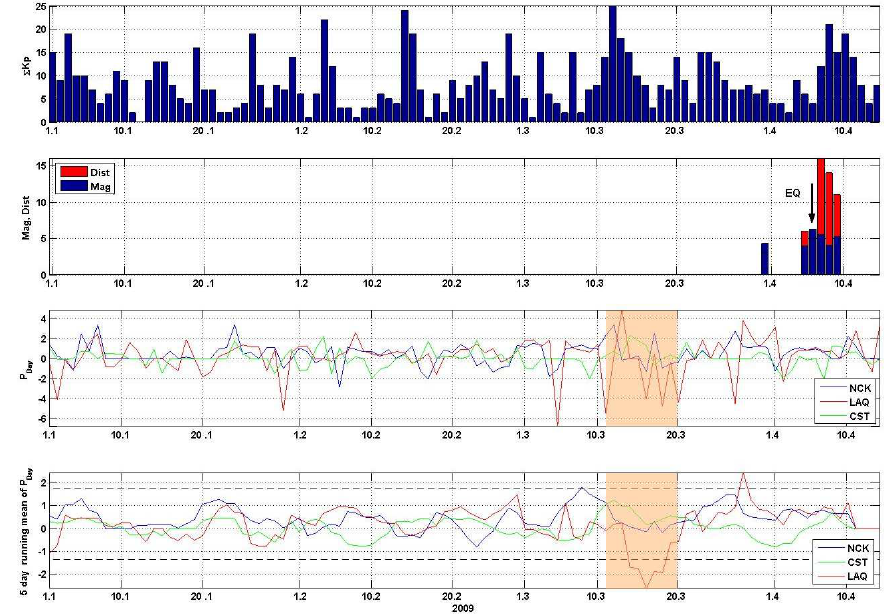
Fig. 6. Top P K p , magnitude of seismic events and distance to L’Aquila, standardized polarization from 1 January 2009 to 14 April 2009 and 5 day running mean of standardized polarization for CST, NCK, and LAQ station. Time periods probably affected by ULF events due to seismic activity are color